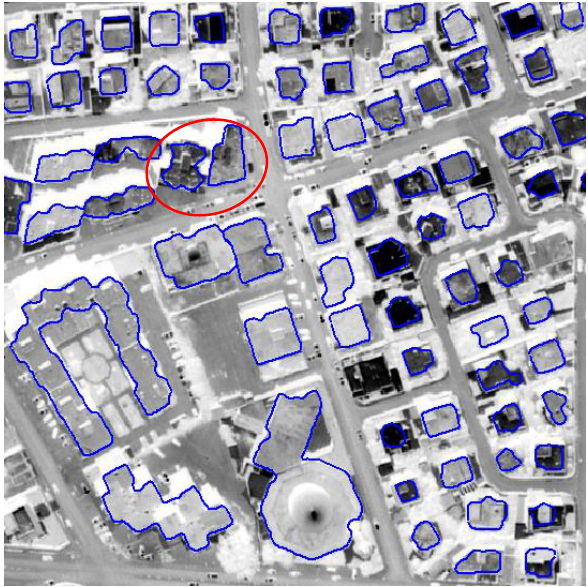
Figure 5. Results of EG_AC upon PCA image in level2 of building extraction. In the red region, the algorithm wrongly detects two distinct building instead of one building.